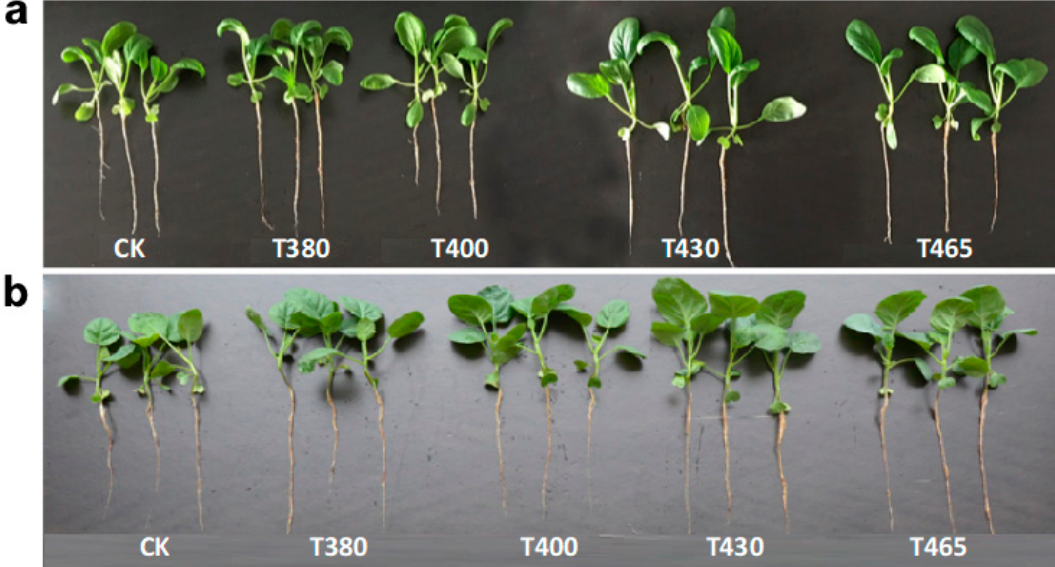
Figure9. Thetwobaby-leavesmorphology10daysaftertreatments. Themorphologyof( a )Pak-choiand ( b ) Chinese kale. CK = control. T380, T400, T430, and T465 = supplemented wavelength at 380, 400, 430, and 465